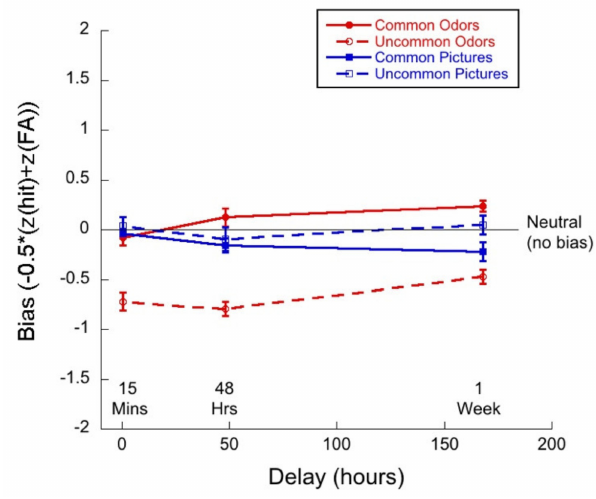
Figure 7. Bias as a function of delay for each of the four test